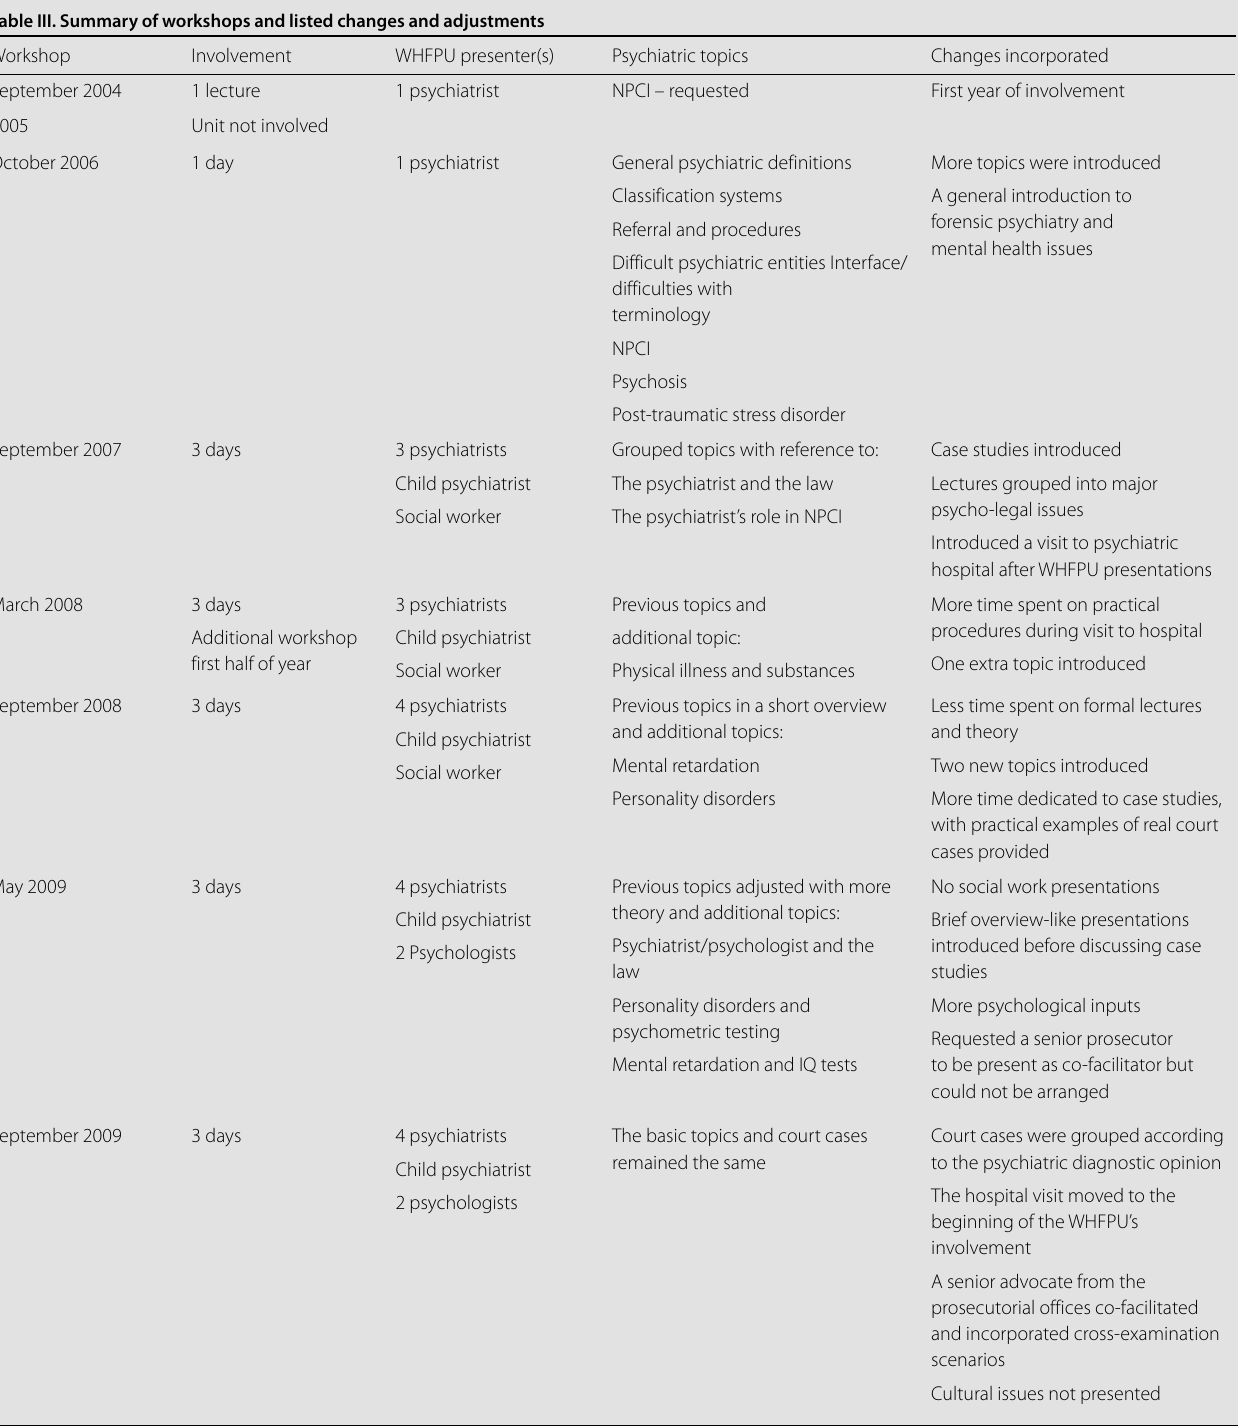
Table III. Summary of workshops and listed changes and adjustments